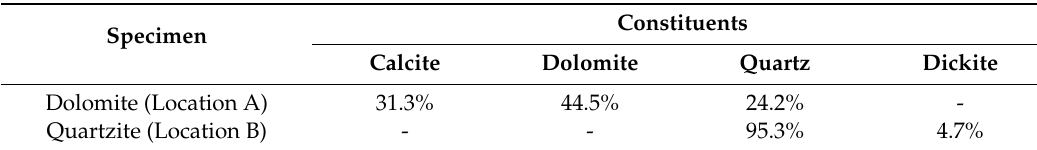
Table 1. Results of X-ray diffraction (XRD) in Ny-Ålesund.